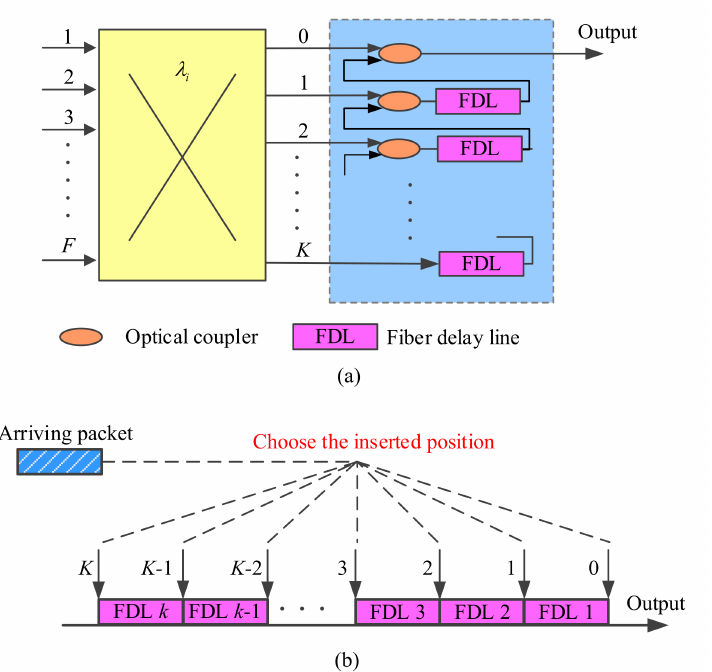
Figure 2. ( a ) The detailed architecture of the concentrator. ( b ) Operation of the concentrator for arriving